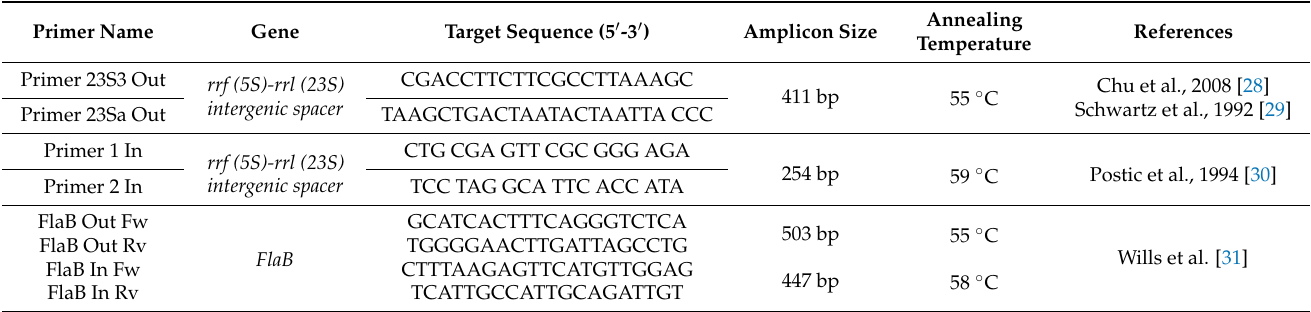
Table 1. Inner and outer primers for nPCR of Borrelia burgdorferi s.l. FlaB and 5S-23S intragenic